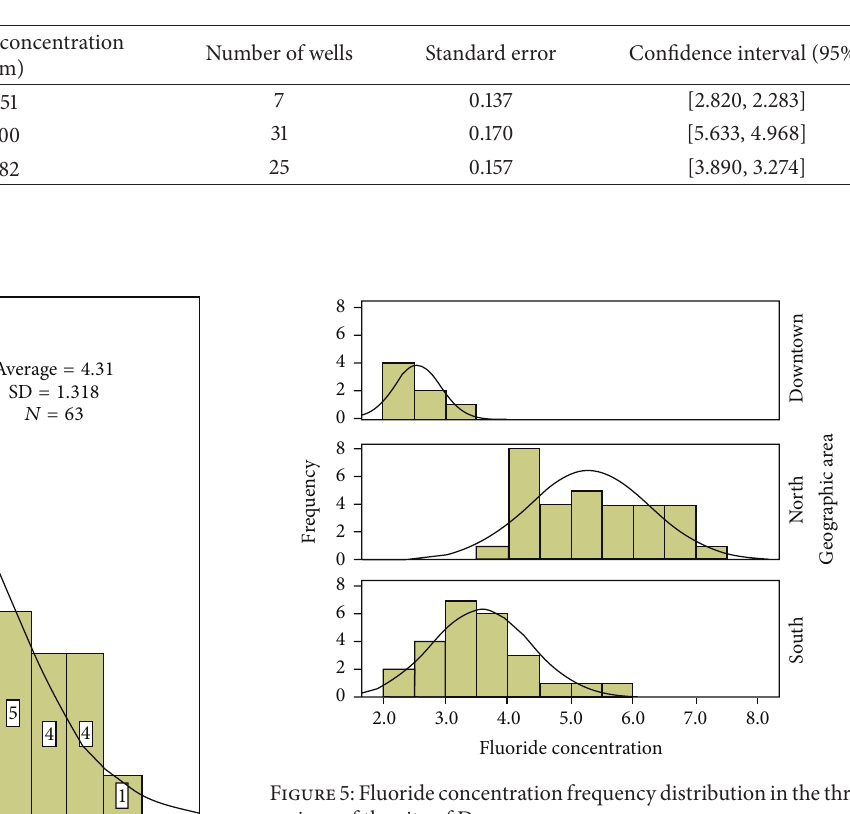
Table 1: Mean fluoride concentrations by region in the city of Durango. The three geographic regions yielded significantly different values using ANOVA ( 𝑃 < 0.00 ).